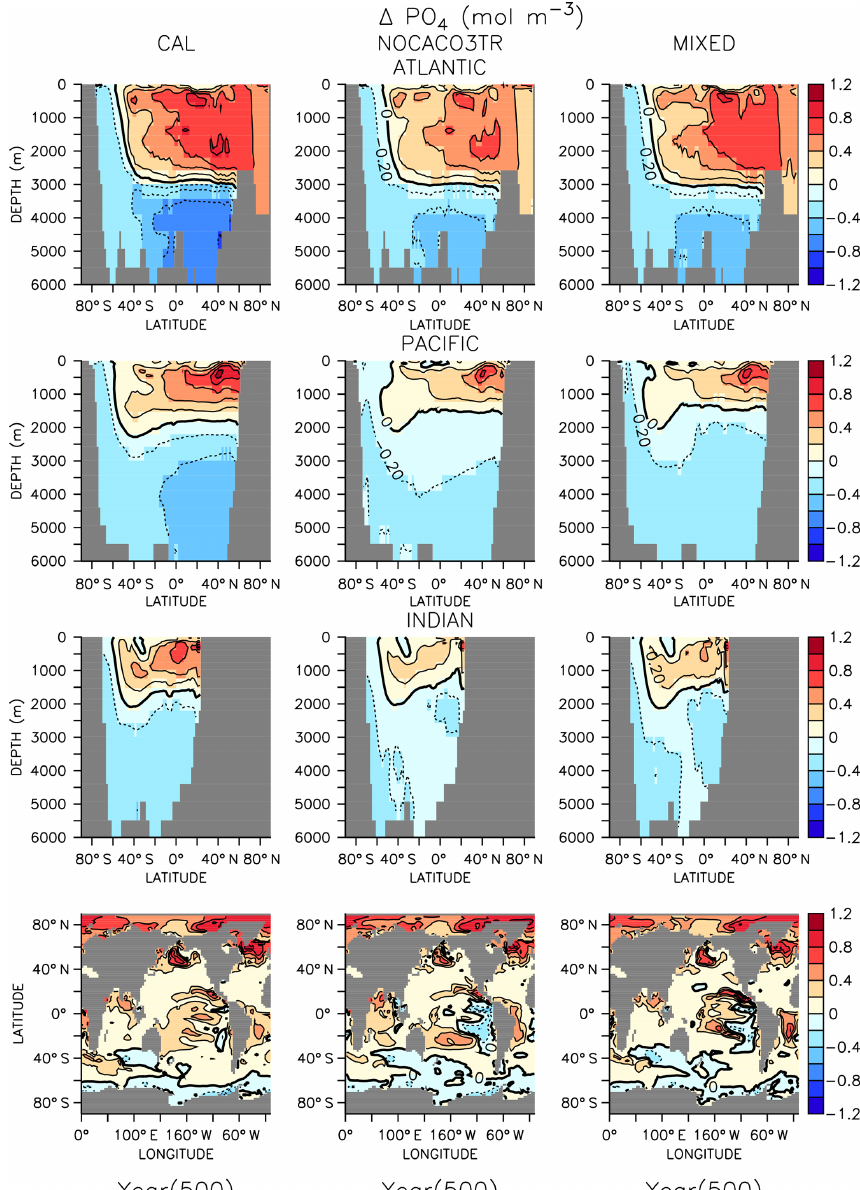
Figure 5. Zonally averaged changes in phosphate concentration over the COOLING simulation. Bottom row shows changes at the